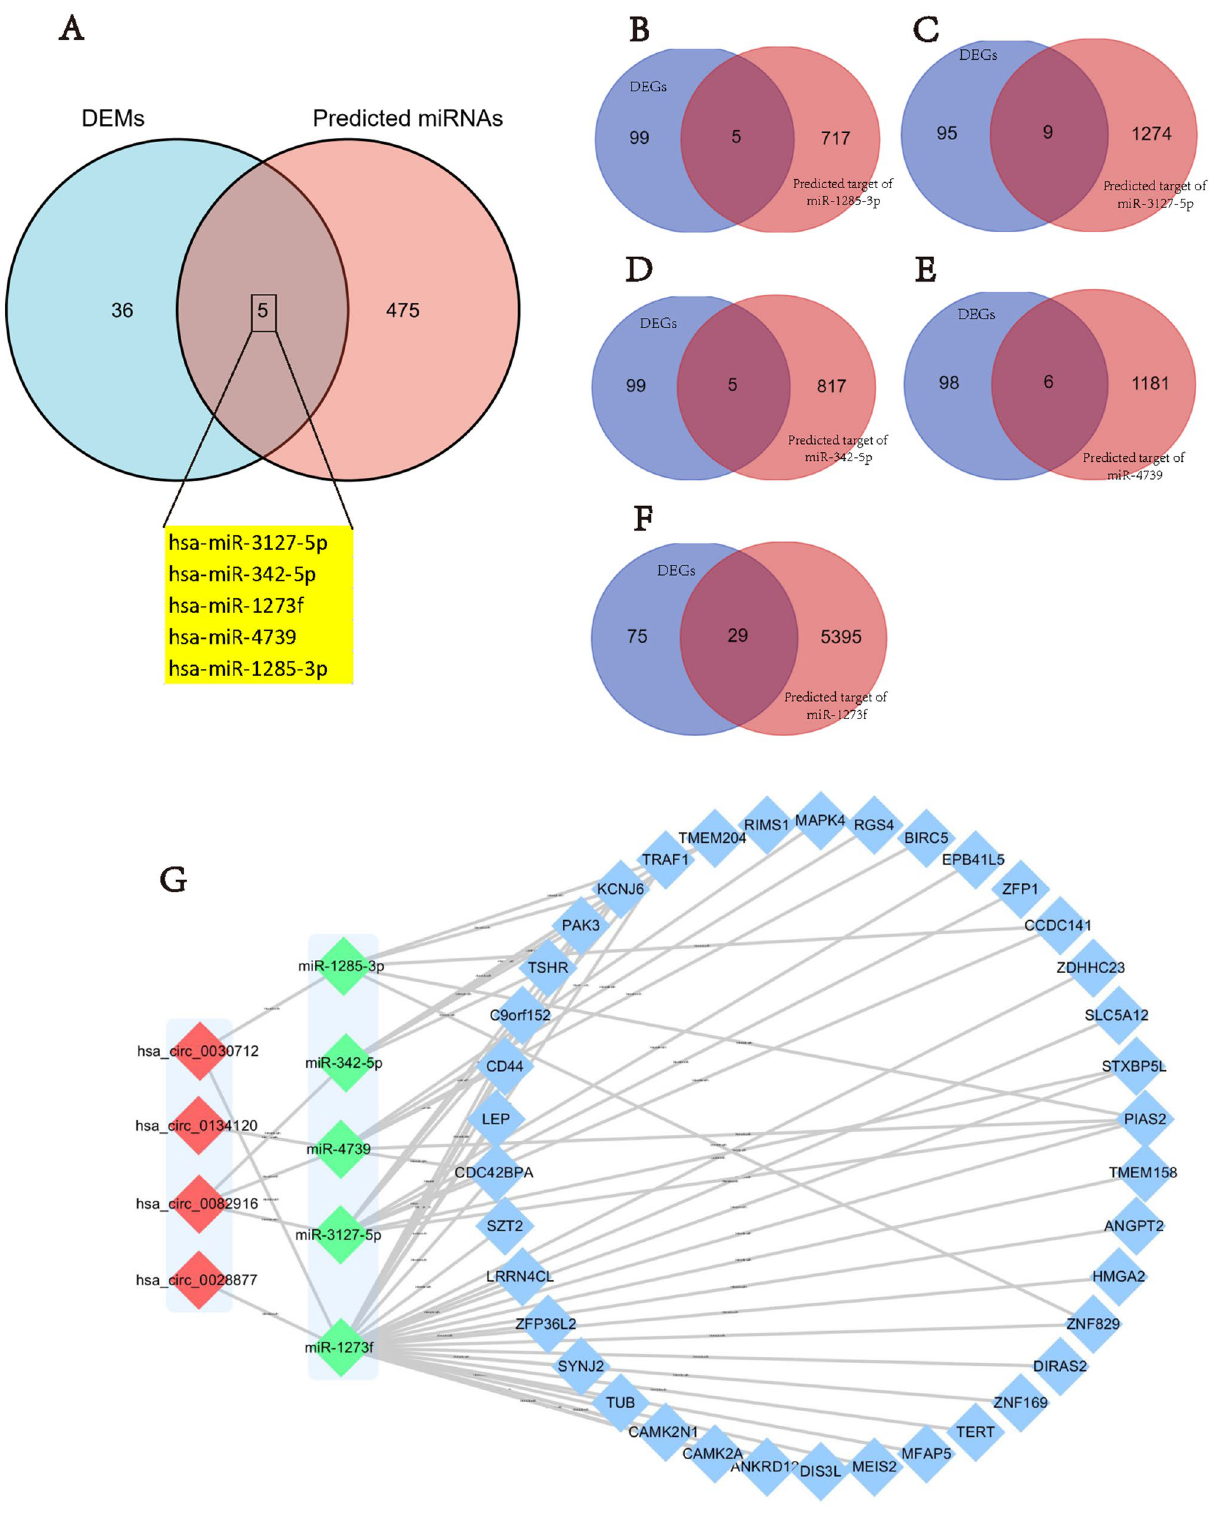
Figure 4. Identification of the target miRNAs and target genes and construction of the circRNA–miRNA– mRNA network. ( A ) Identification of the target miRNAs, ( B – F ) Identification of the target genes by Venn analysis, ( G ) CircRNA–miRNA–mRNA